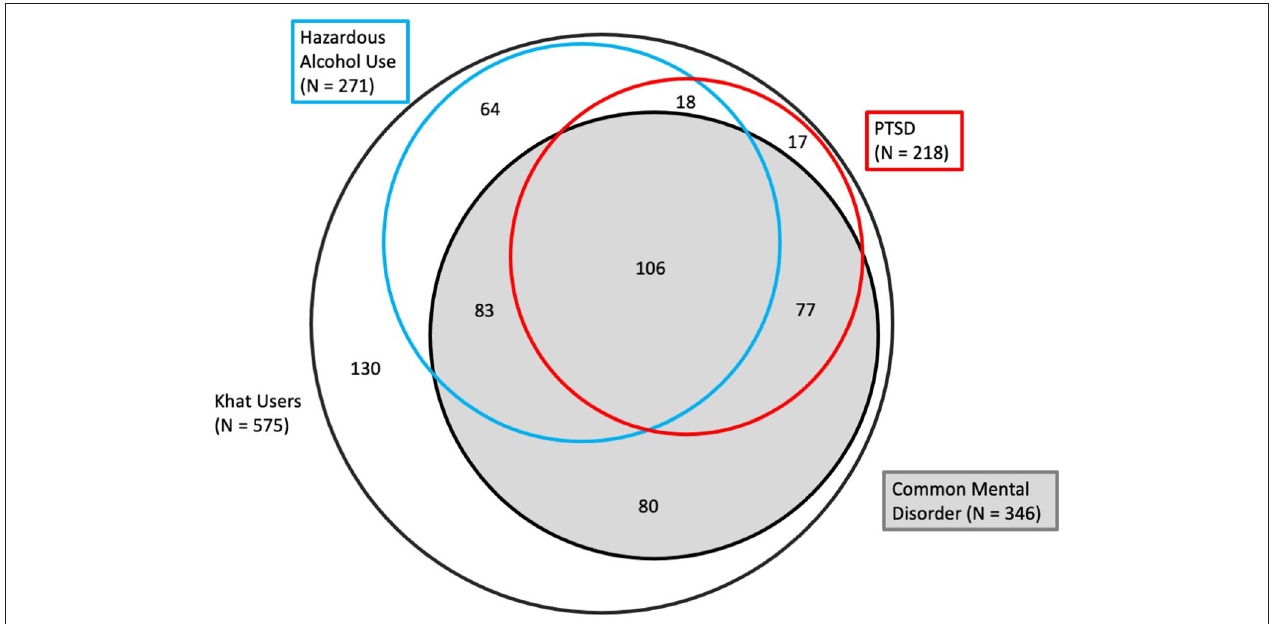
FIGURE 1 | Venn Chart, displaying the overlap between groups of cases screening positive for Common Mental Disorders (CMD), PTSD and hazardous alcohol use among 575 students seeking for treatment because of their khat use (areas in the chart are approximately proportional to the size of the respective